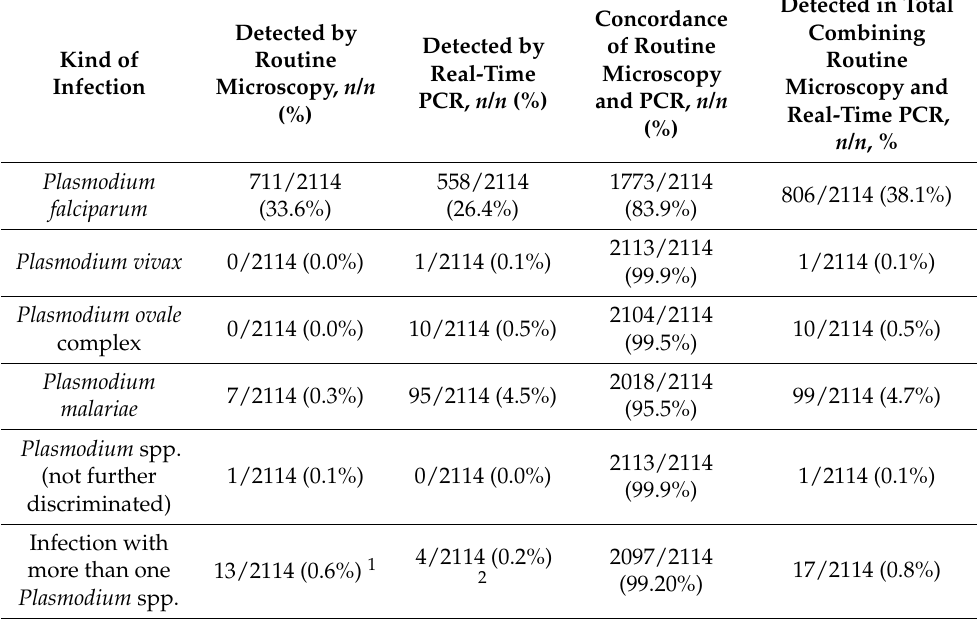
Table 4. Distribution of Plasmodium species either by routine microscopy or PCR-based detection in the incubated blood culture materials. Only samples are shown that had been assessed by both microscopy and PCR ( n =